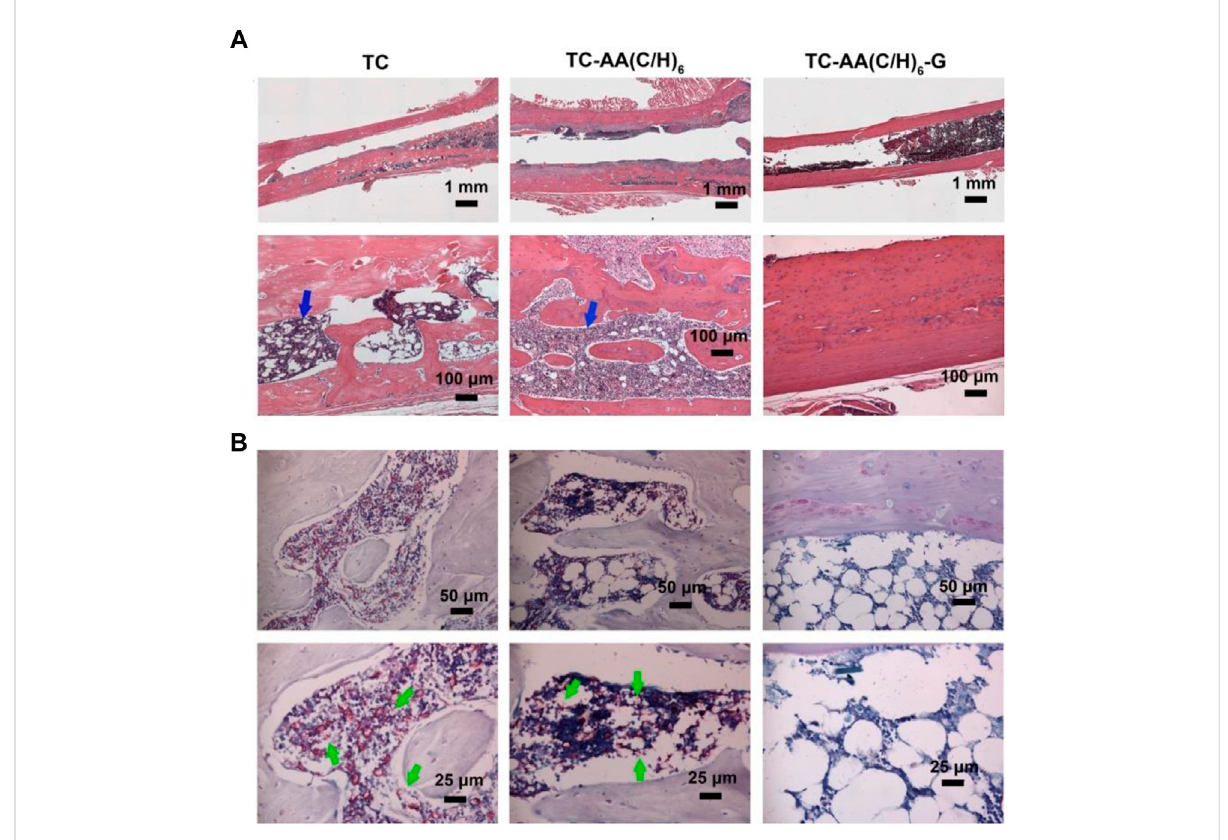
FIGURE 10 Representative photomicrographs of longitudinal sections of femurs. (A) H&E staining; (B) Giemsa